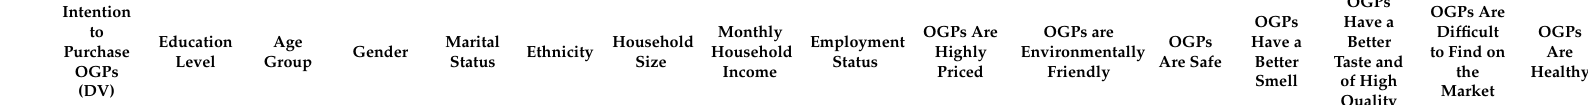
Monthly Employment Household Household Status Size Income